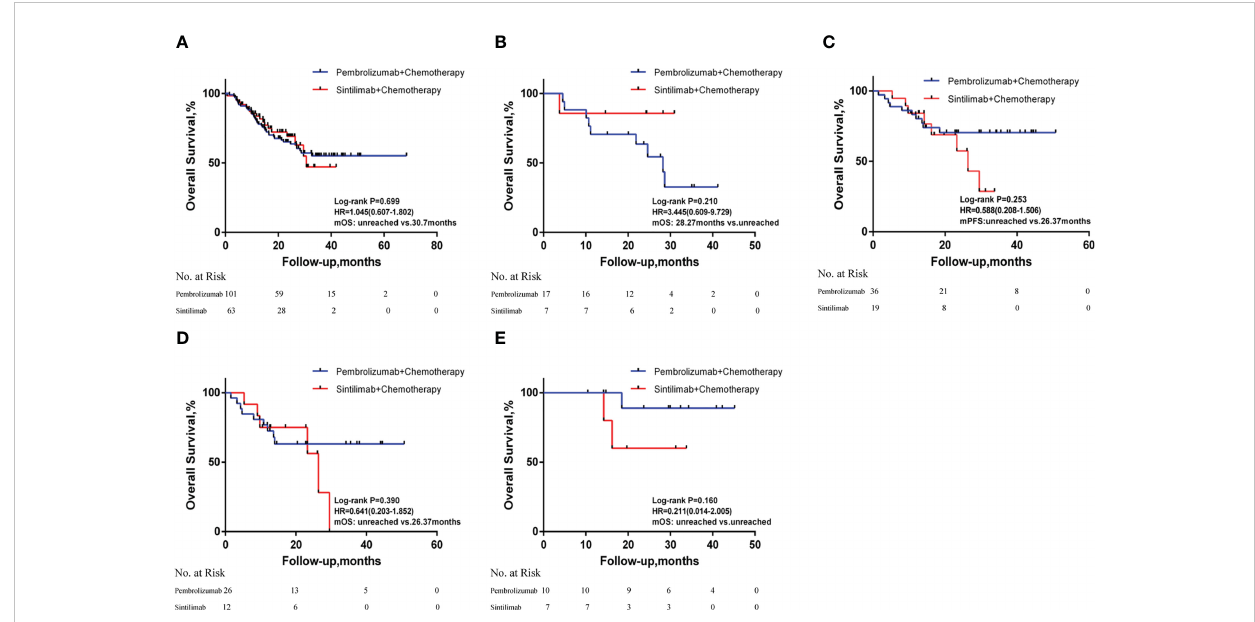
FIGURE 3 Kaplan-Meier curves of overall survival in (A) all patients; (B) patients with negative PD-L1 expression; (C) patients with positive PD-L1 expression; (D) patients with low PD-L1 expression and (E) patients with high PD-L1 expression. HR, hazard ratios; mOS, median overall survival; PD-L1, programmed death-ligand 1.